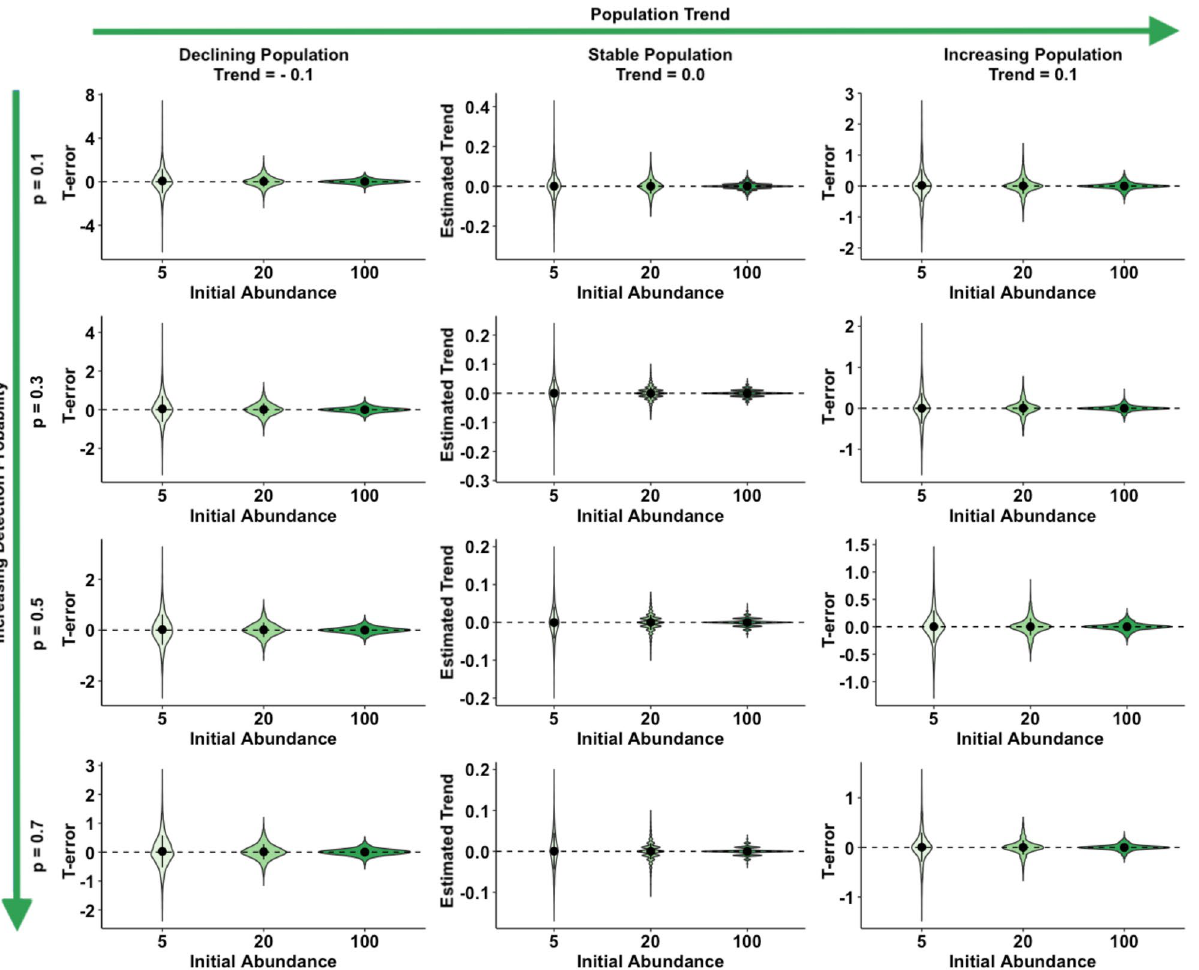
Figure 1. Violin plots of the observed error in trend estimation (T-error) for several scenarios, according to different levels of population trend, detection probability, and initial abundance. Black dots and vertical bars inside each violin plot represent the mean and standard deviation,